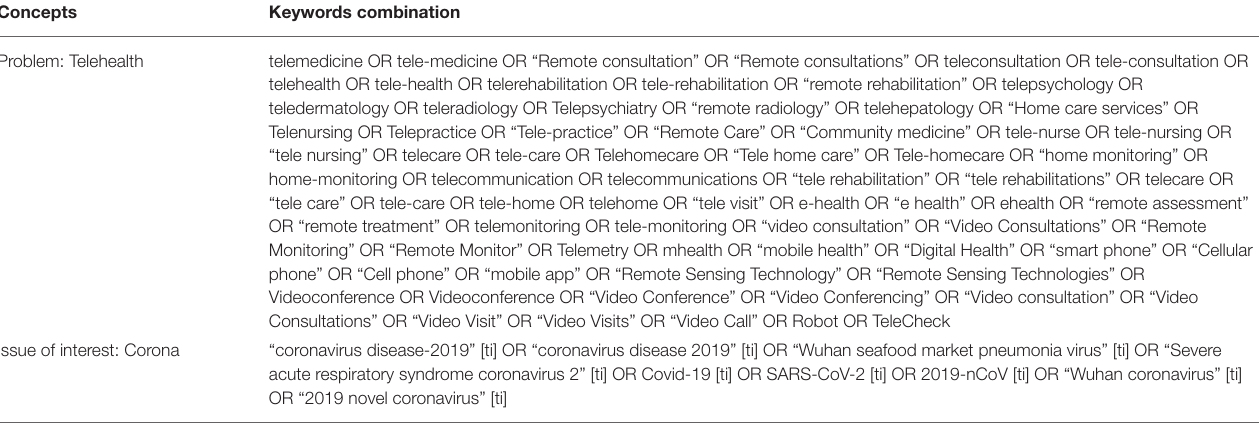
TABLE 1 | Keywords and controlled vocabulary terms combination in the search strategy based on PICO